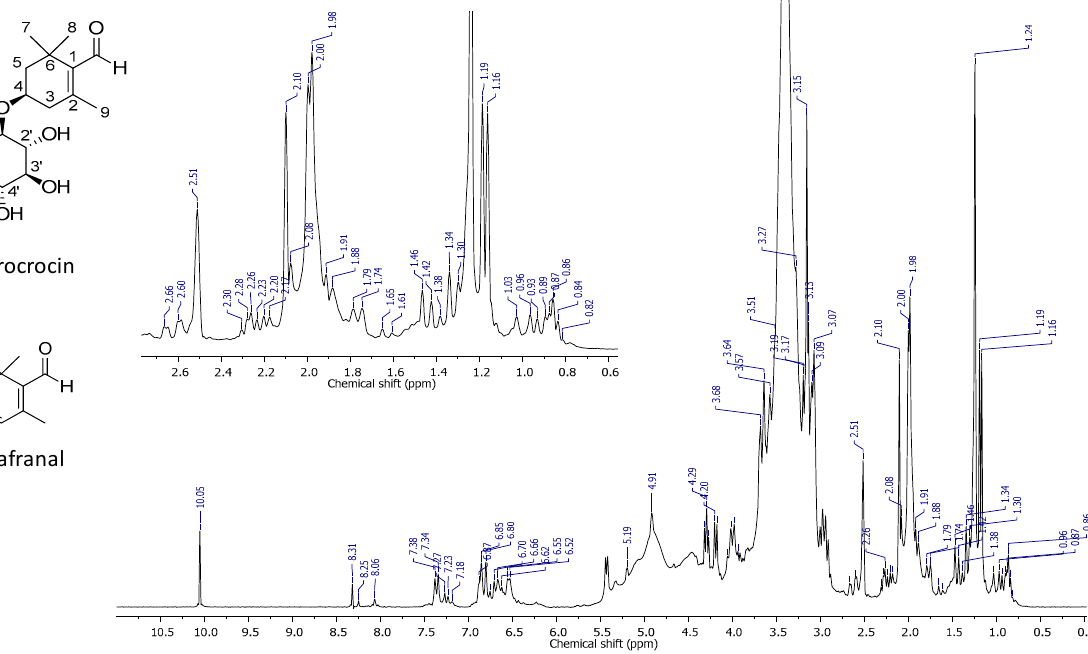
Figure 1. High-resolution 1 H NMR spectrum of PEF.